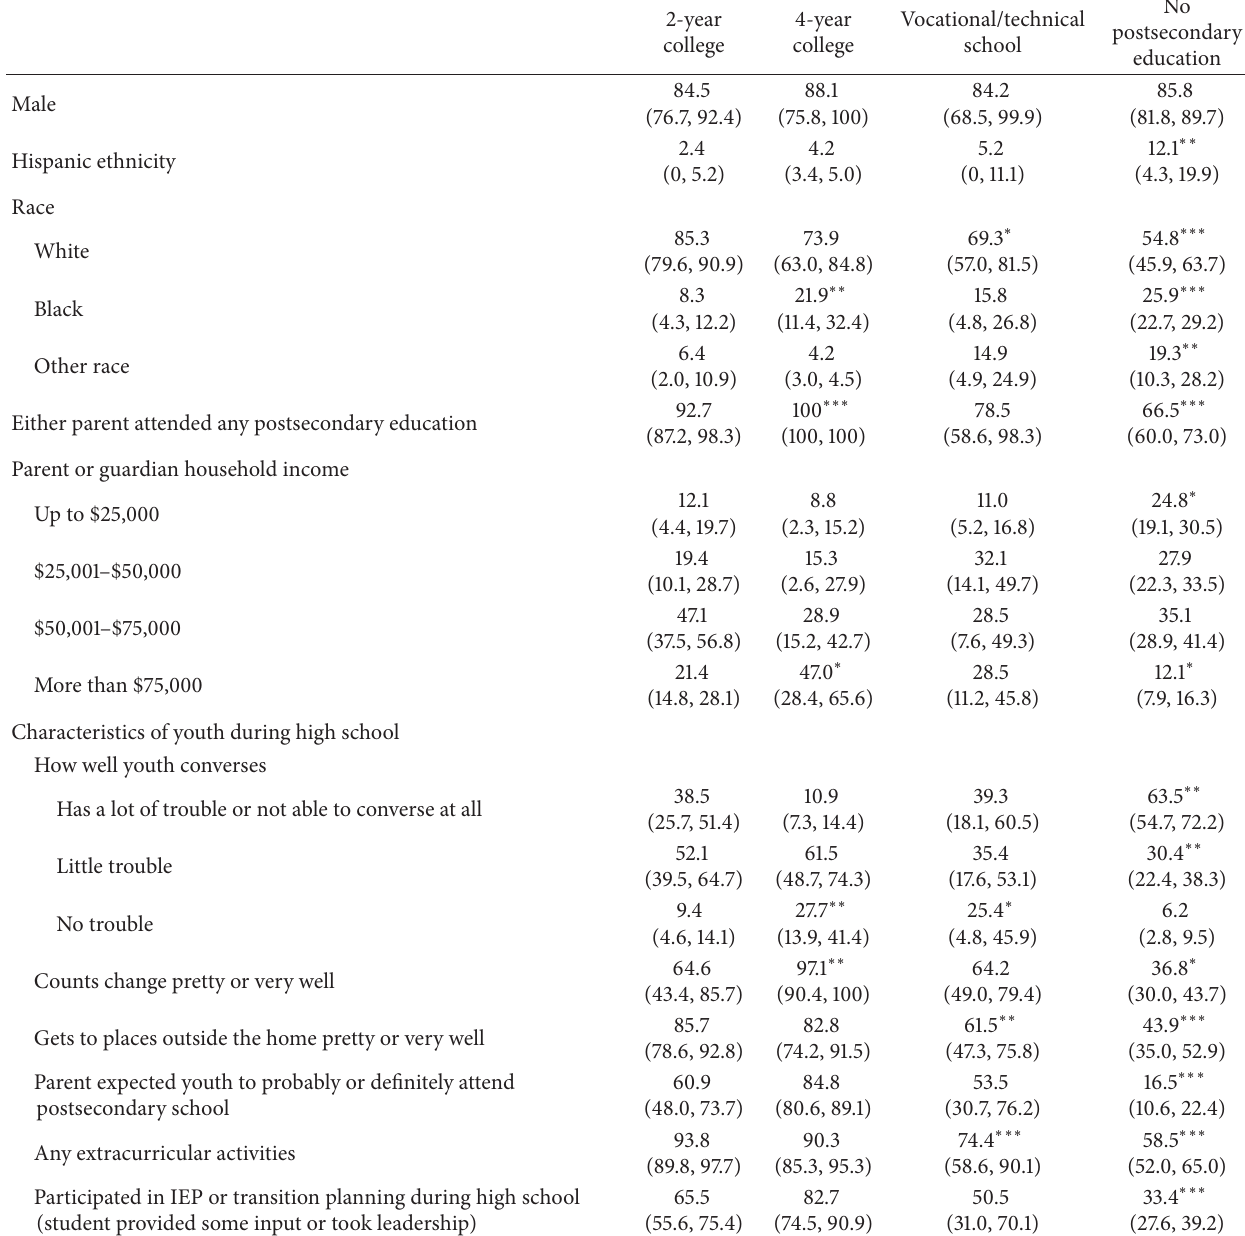
Table1:Demographicanddisabilitycharacteristicsofstudentsontheautismspectrumacrosspostsecondaryeducationoutcomes.Percentage (95% confidence interval), test for difference versus the 2-year college